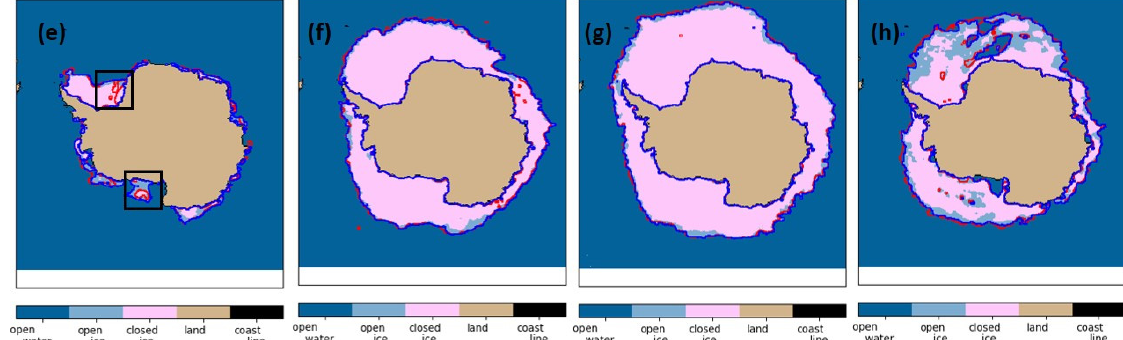
Figure 15. Comparison of sea ice edge from CSCAT retrieved result (red line) and NSIDC 40% SIC isoline (blue line): ( a )